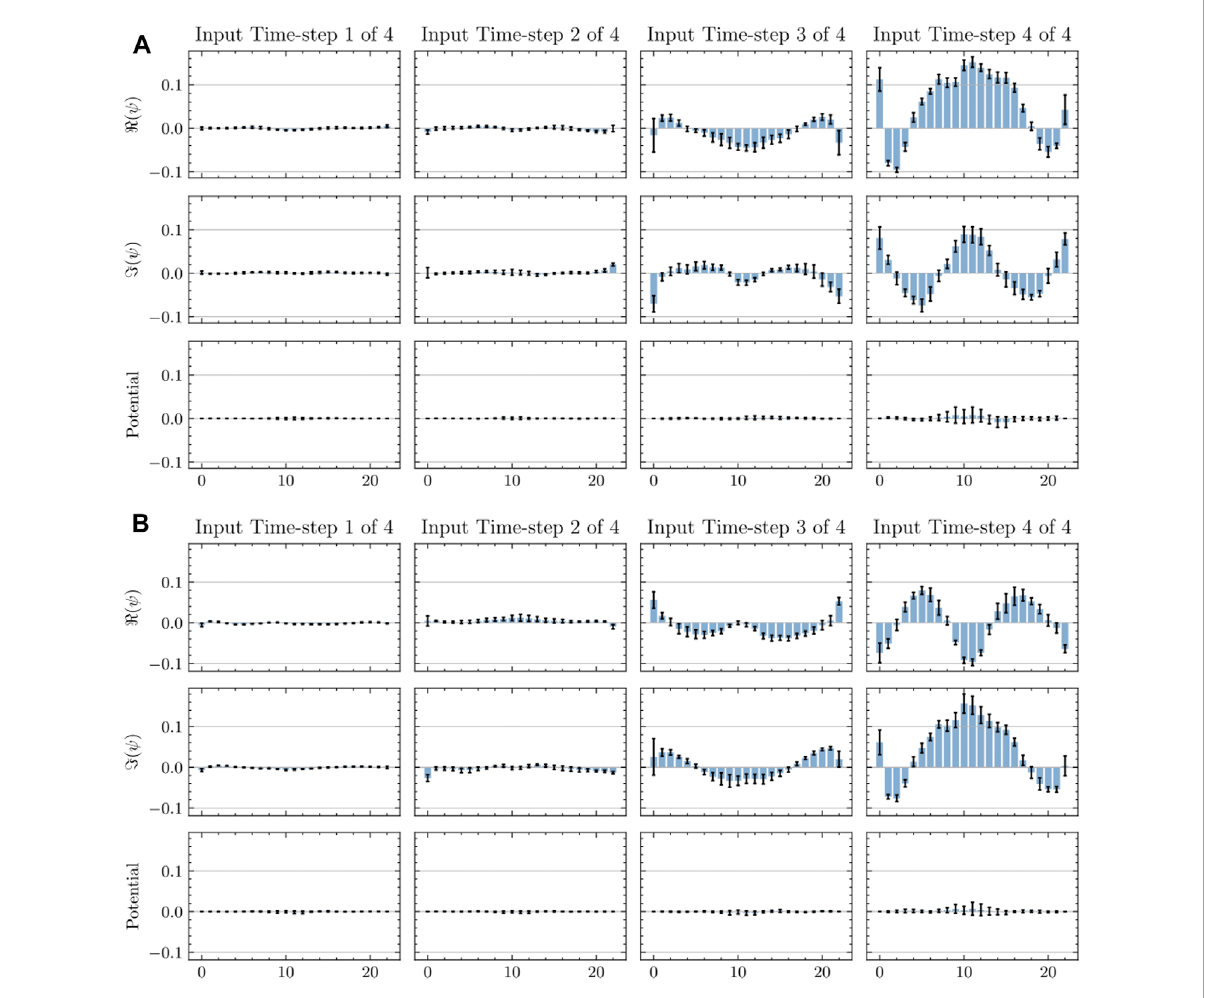
FIGURE 8 Average direct gradients. (A) , The averaged direct gradients of the real part of the center pixel of the output window. (B) , The averaged direct gradients of the imaginary part of the center pixel of the output window. The bars represent the average value, and the black line the standard